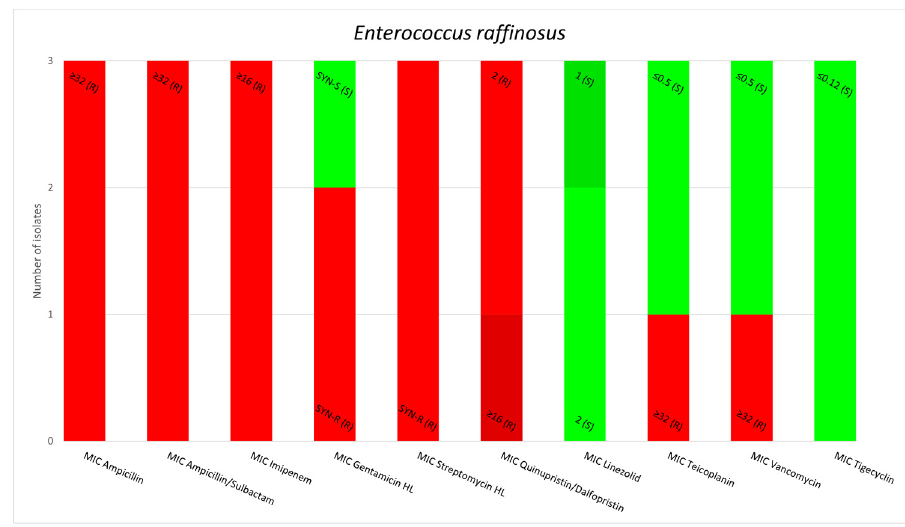
Figure 1. Minimum inhibitory concentrations patterns in E. gallinarum , E. avium , E. raffinosus , E. casseliflavus and E. durans .